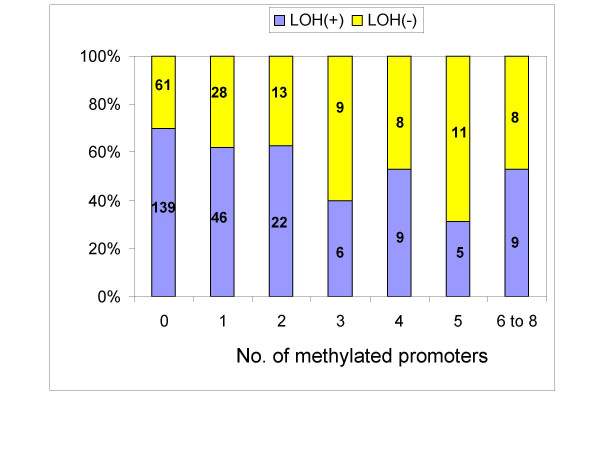
Frequency of 18q LOH in MSI-L/MSS colorectal cancers, according to the number of methylated promoters. CIMP-0 tumors (N = 200) with 0 methylated promoters show the highest frequency of 18q LOH.